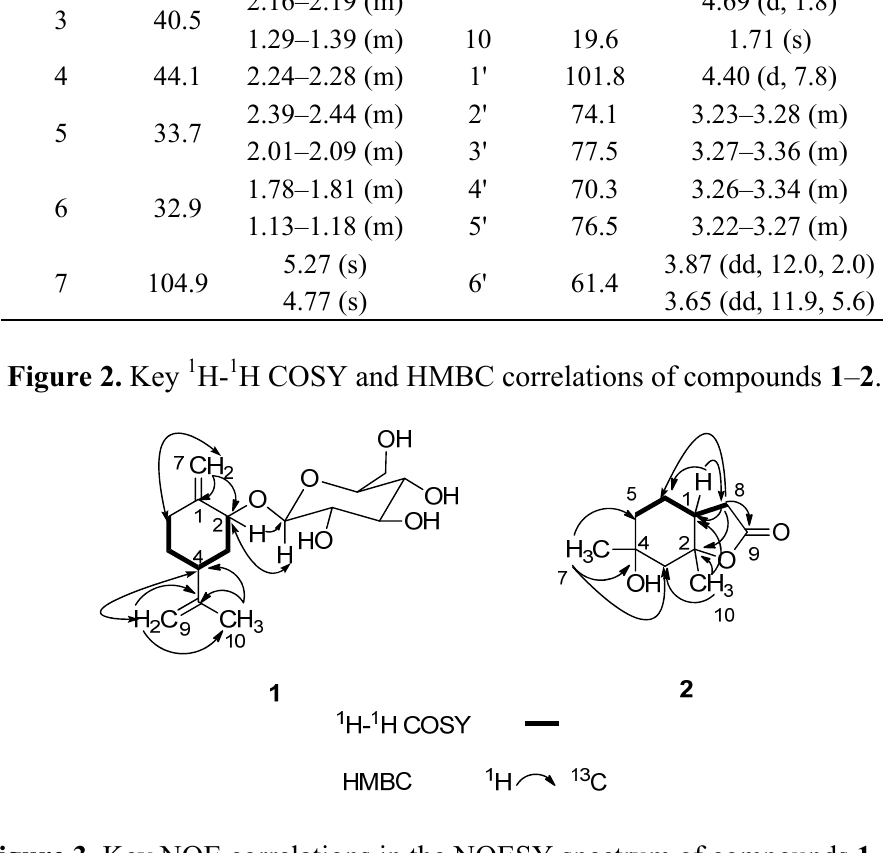
OD) of compound 1 . 3